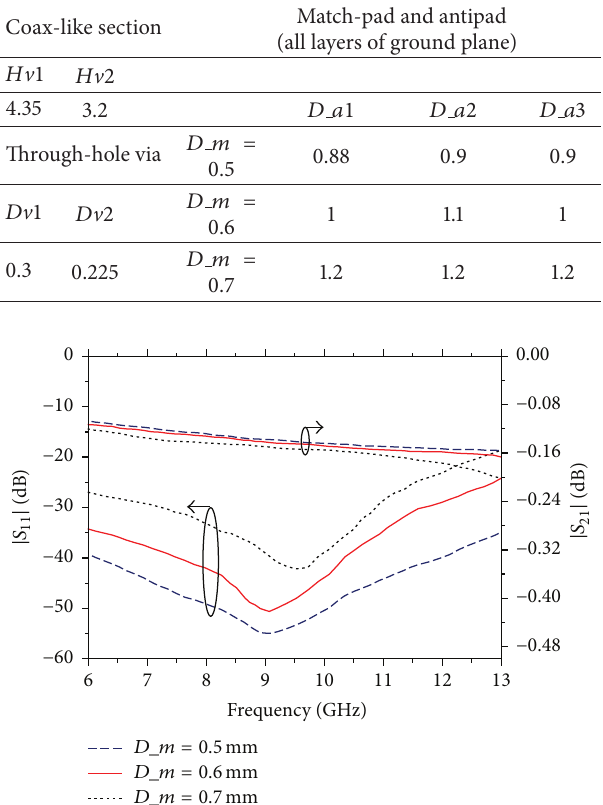
Table 2: Parameters of matching pads loaded signals via transition investigation (unit: mm).